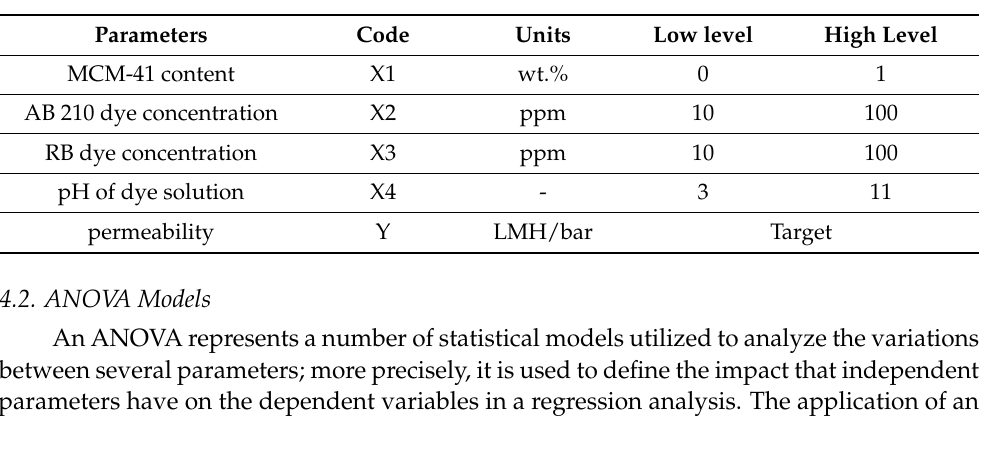
Table 3. Values and codes of the experimental variables at various